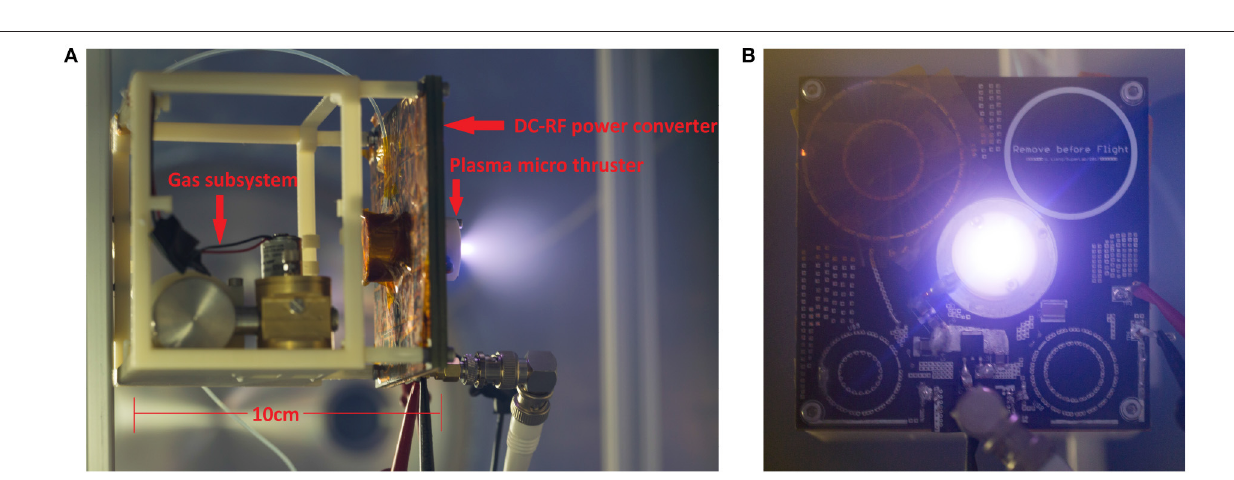
FIGURE 5 | Operational testing of the integrated micro-thruster/power inverter 1 U CubeSat assembly in the ANU WOMBAT space simulation facility (A) side-view also showing gas subsystem integrated prototype [44]. (B) front-view demonstrating successful vacuum testing (no parasitic discharge) under space